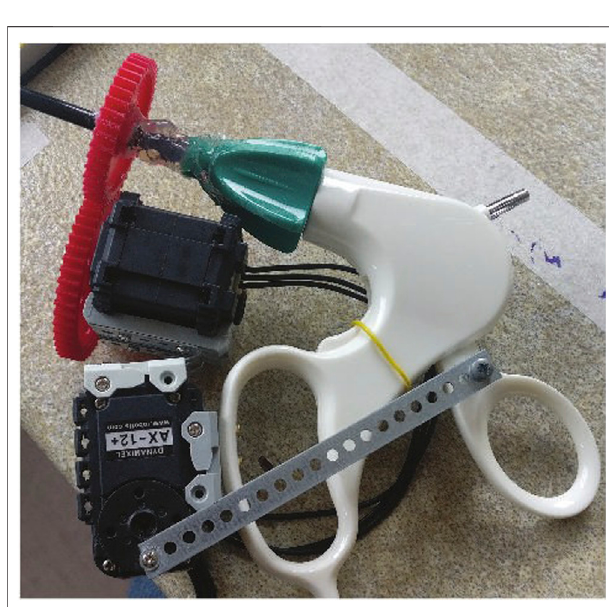
FIGURE 4 | Two Dynamixel servos mounted on the forcep to control third rotational axis and grasping